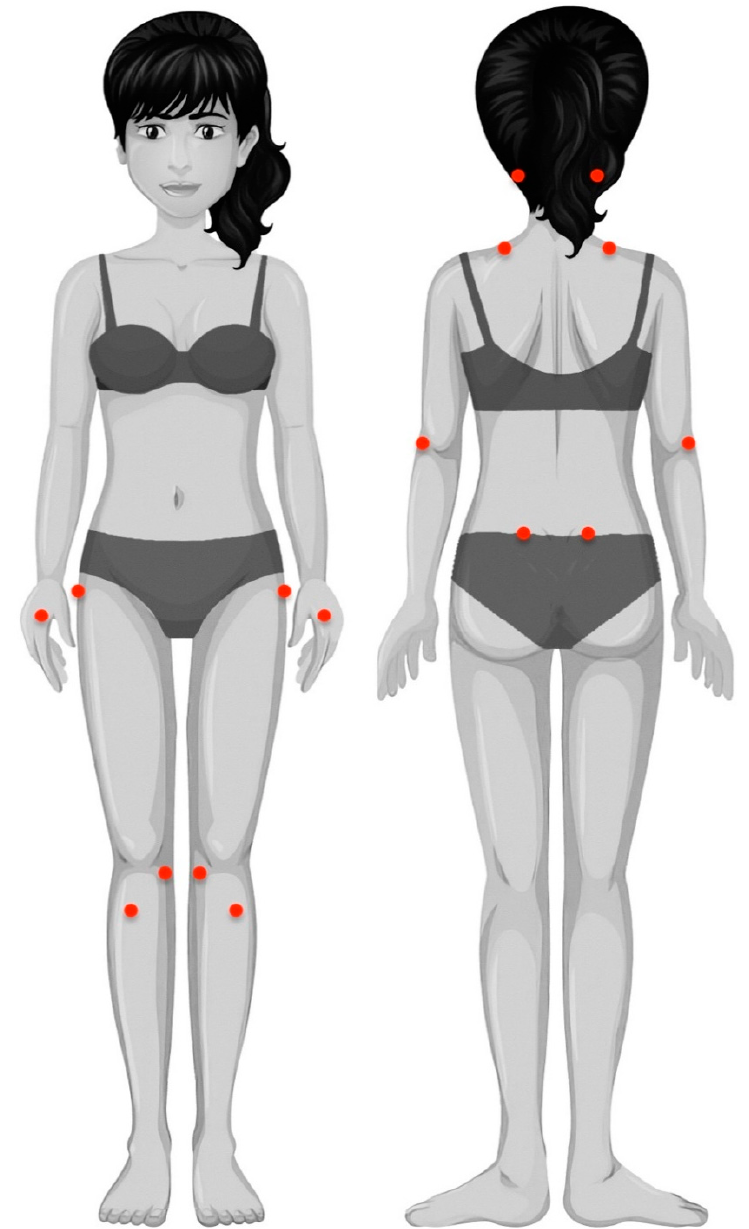
Figure 1. Location of pressure pain threshold measurements: mastoid process, upper trapezius muscle, lateral epicondyle, second metacarpal, posterosuperior iliac spine, greater trochanter, pes anserine, and tibialis anterior muscle.